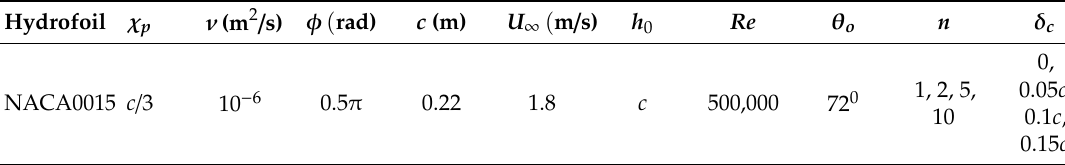
Table 1. Simulation